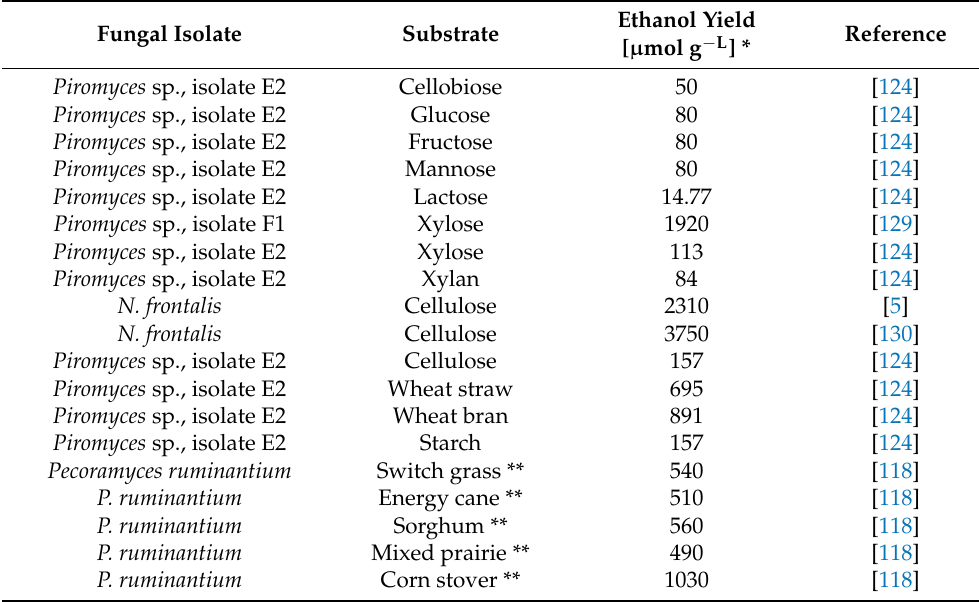
Table 1. Ethanol production by anaerobic